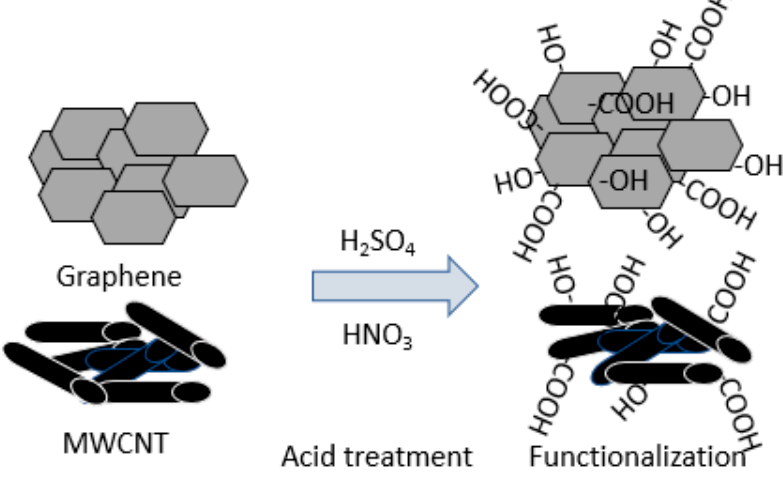
Figure 2. Schematic representation of the functionalization reaction of GNF and MWCNT.